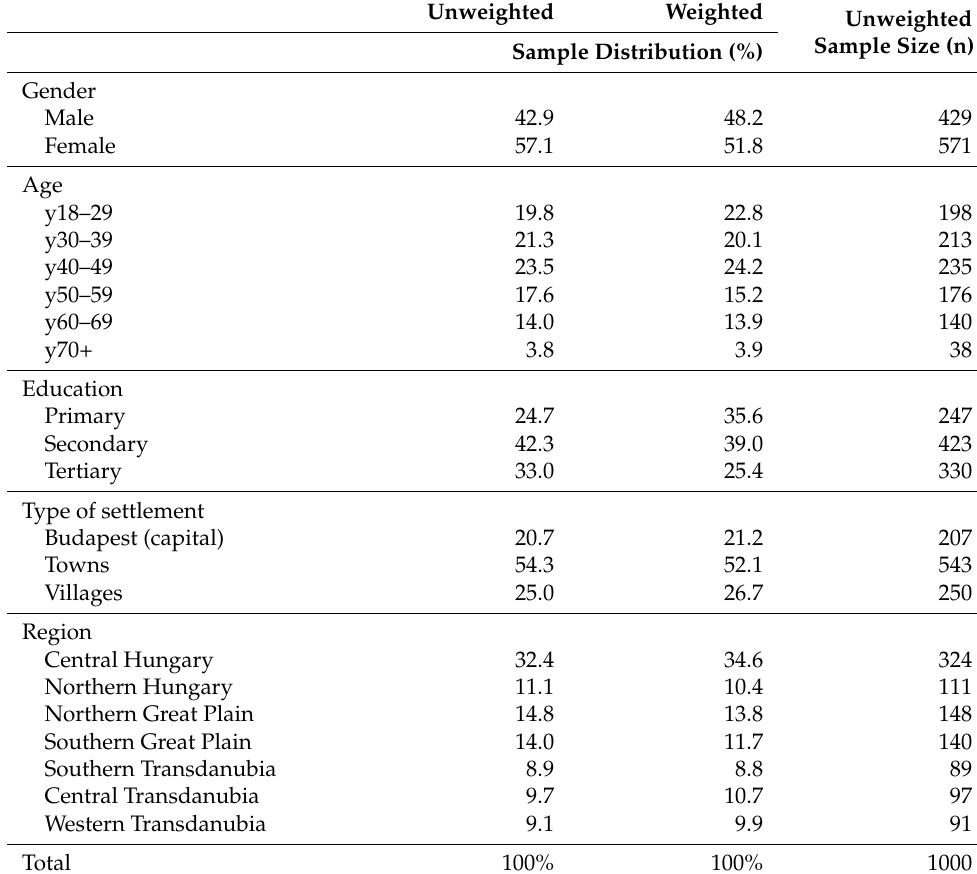
Table A1. Sample characteristics by sample size, unweighted and weighted sample